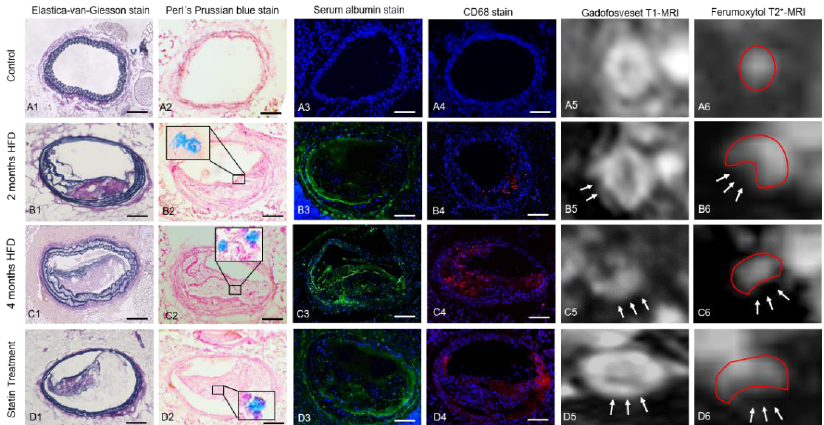
Figure 2. MRI and histological analysis of brachiocephalic tissue. ( A1 – D4 ): Histologically stained cross-sectional slices of the brachiocephalic artery, ( A1 – D1 ) Elastica-van-Giesson stain, ( A2 – D2 ) Perls’ Prussian blue stain, ( A3 – D3 ) immunofluorescence serum albumin stain, ( A4 – D4 ) immunofluorescence CD68 stain of control mice and ApoE -/- -mice fed with HFD for 2 and 4 months as well as a statin treatment group. The scale displays 100 µm. ( B2 ), ( C2 ), ( D2 ) The enlarged details show iron oxide particle depositions in the plaque. ( A5 – D5 ) and ( A6 – D6 ) T1- and T2*-weighted images corresponding to the histological sections are shown in the first four columns. ( A5 – D5 ) Gadofosveset enhances T1 signal intensity in areas of serum albumin deposition within atherosclerotic plaques. White arrows point to signal-enhanced plaque sites. ( A6 – D6 ) Accumulation of ferumoxytol causes clear areas of signal loss (white arrows) in T2*-weighted images. Signal loss in plaque areas is most conspicuous in the 4 months HFD group. The control group did not show any signal extinction. Red outlines represent the vessel wall delimitation to the extravascular space and the plaque area (signal cancellation in T2*-weighted MRI).